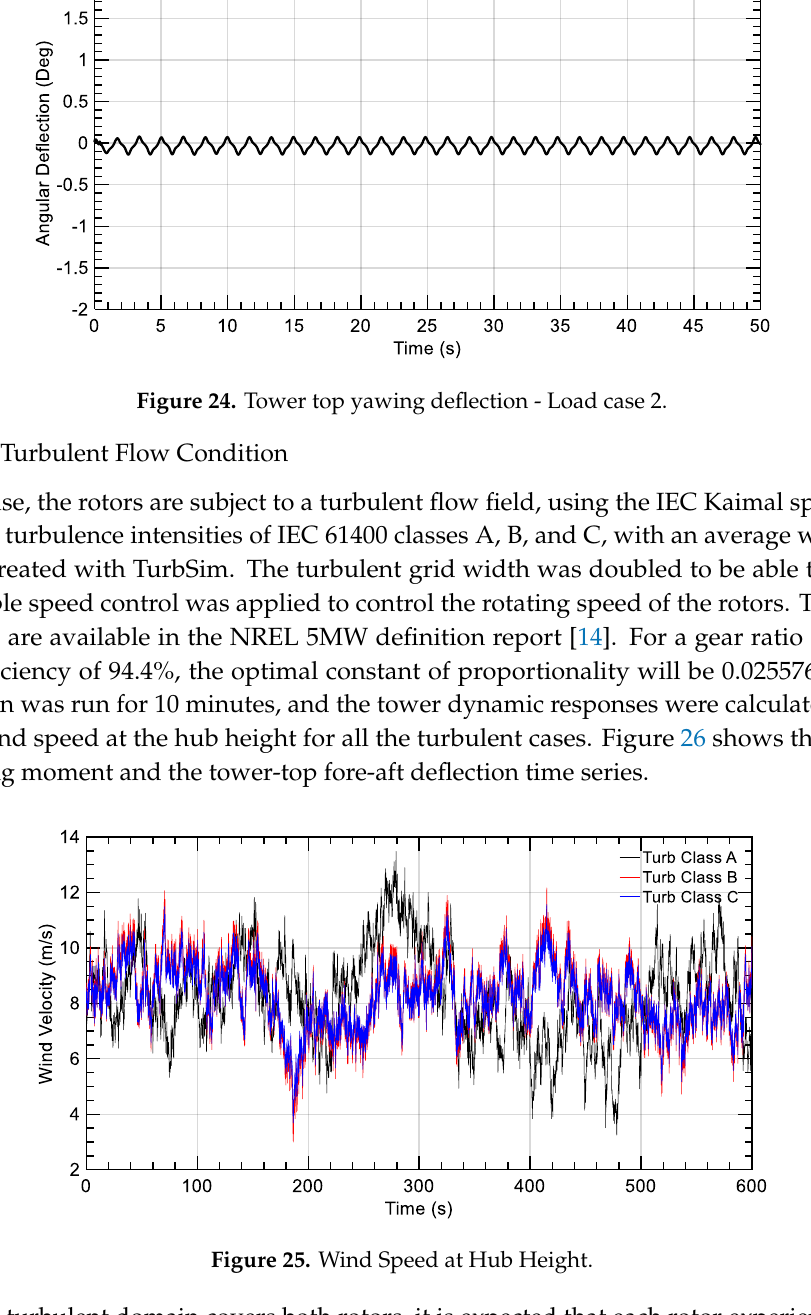
Figure 25. Wind Speed at Hub Height.